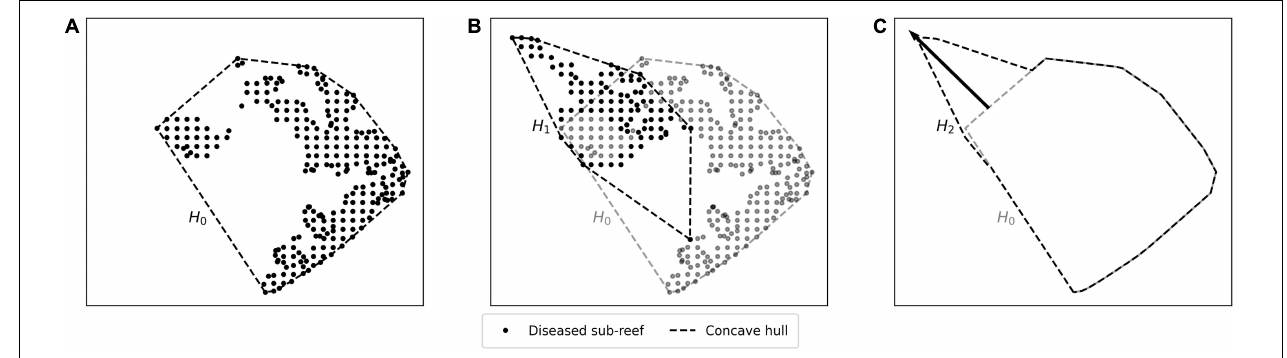
FIGURE 3 | Method used to compute the disease front displacement during a simulated time interval. (A) Concave hull H 0 of the diseased sub-reefs at the beginning of the simulated period. (B) Concave hull H 1 of the sub-reefs diseased during the simulated time interval. (C) Arrow showing the computed front displacement during simulated time interval between H 0 and H 2 , the union of H 0 and H 1 .